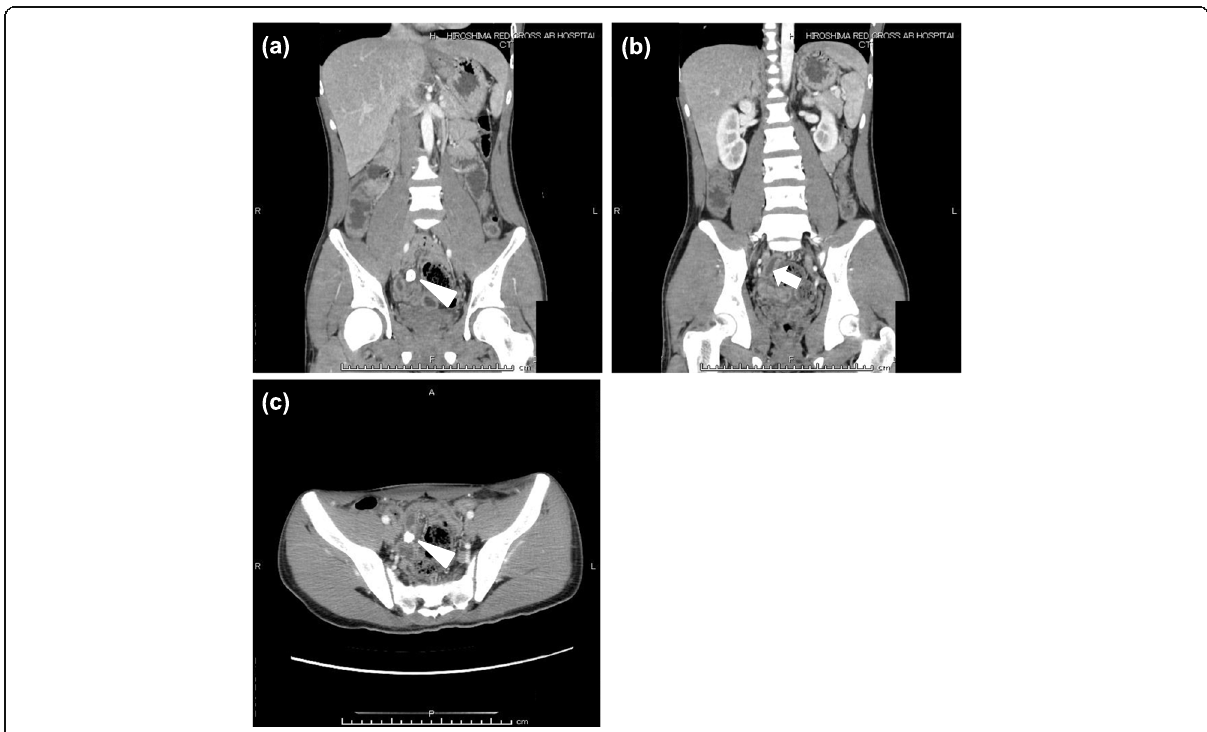
Fig. 2 Preoperative enhanced computed tomography (CT) images. Enhanced a , b coronal and c axial CT images showed an enterolith (arrowhead) in a tubular blind-ending structure, with a thickened and hypercaptant wall